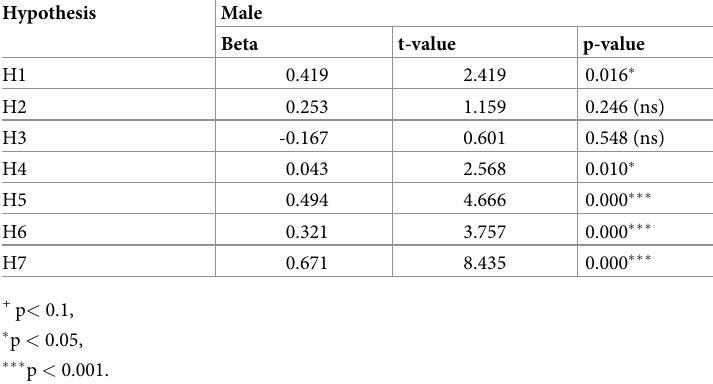
Table 7. Multi-group analysis (gender).